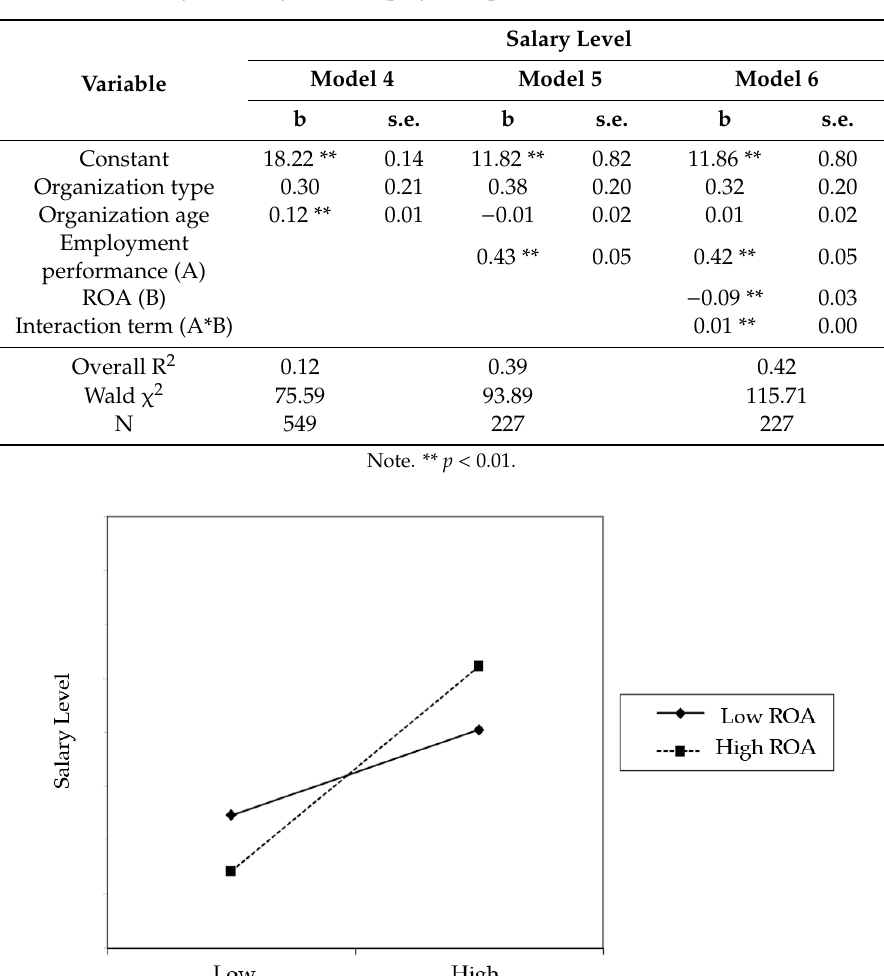
Figure 3. Moderation effect of return on assets.